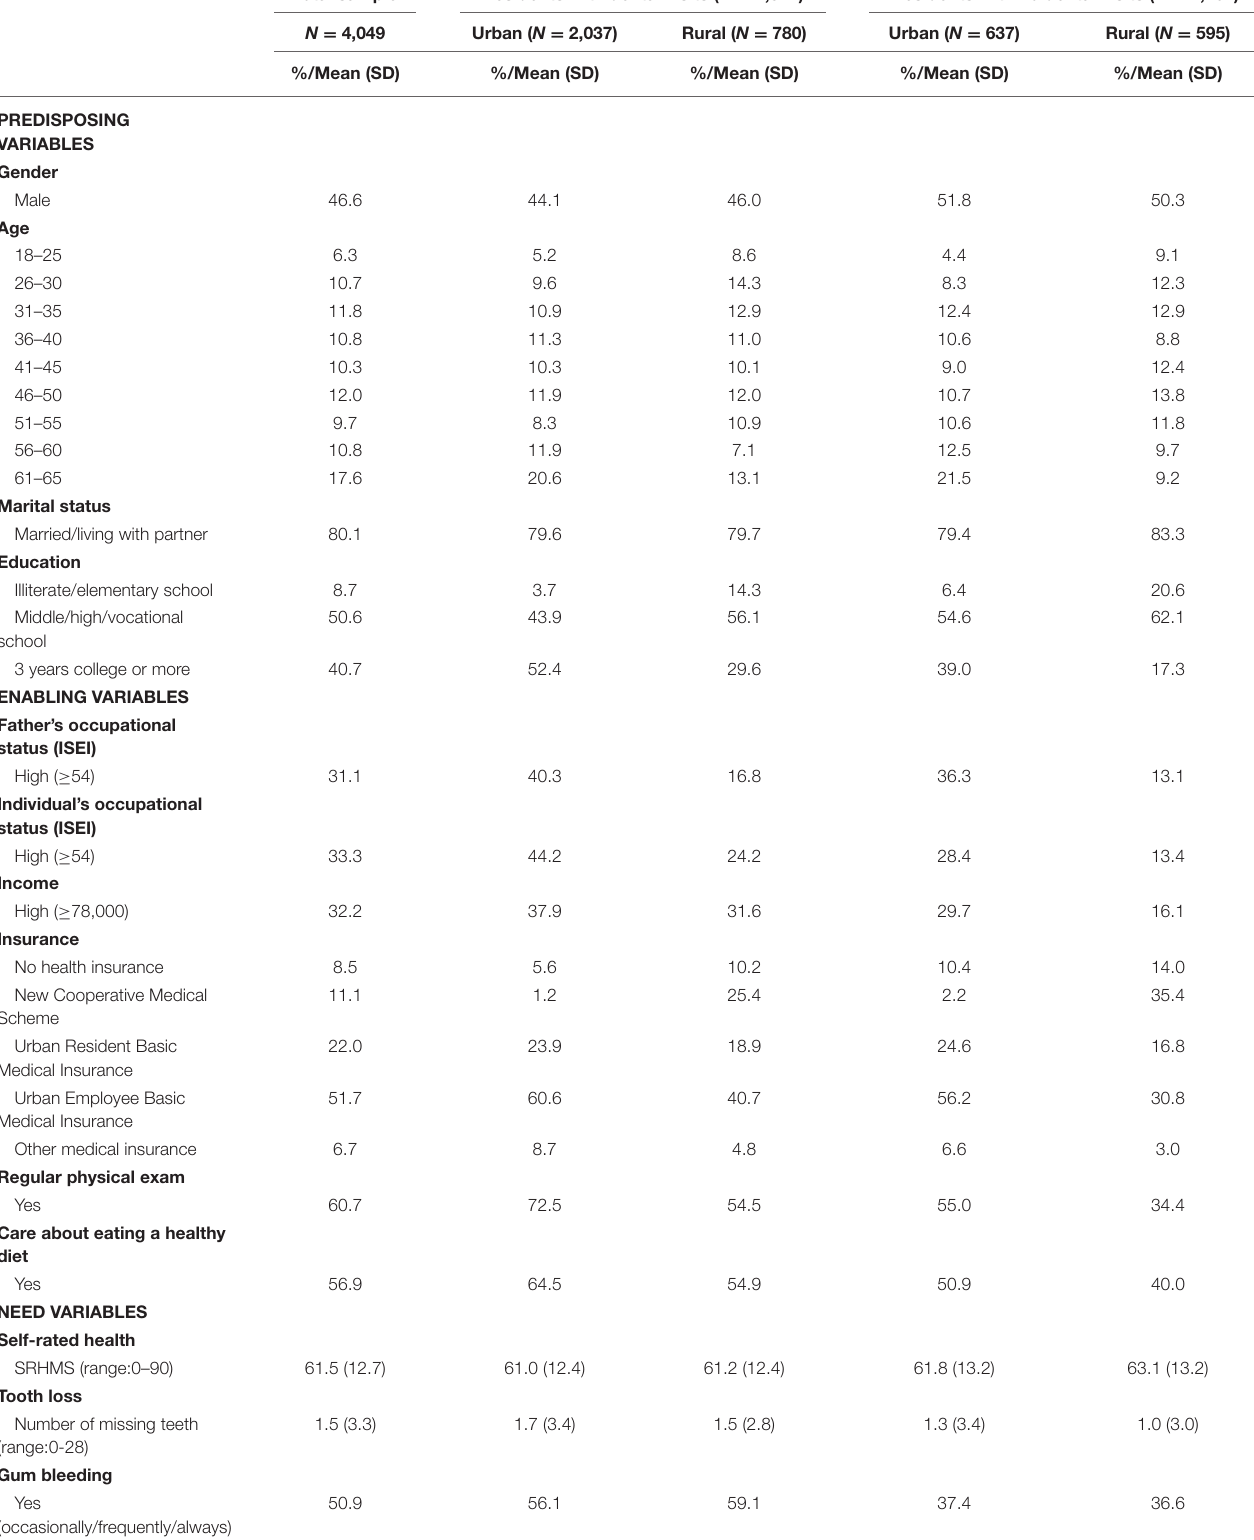
TABLE 1 | Sample characteristics ( N = 4,049,